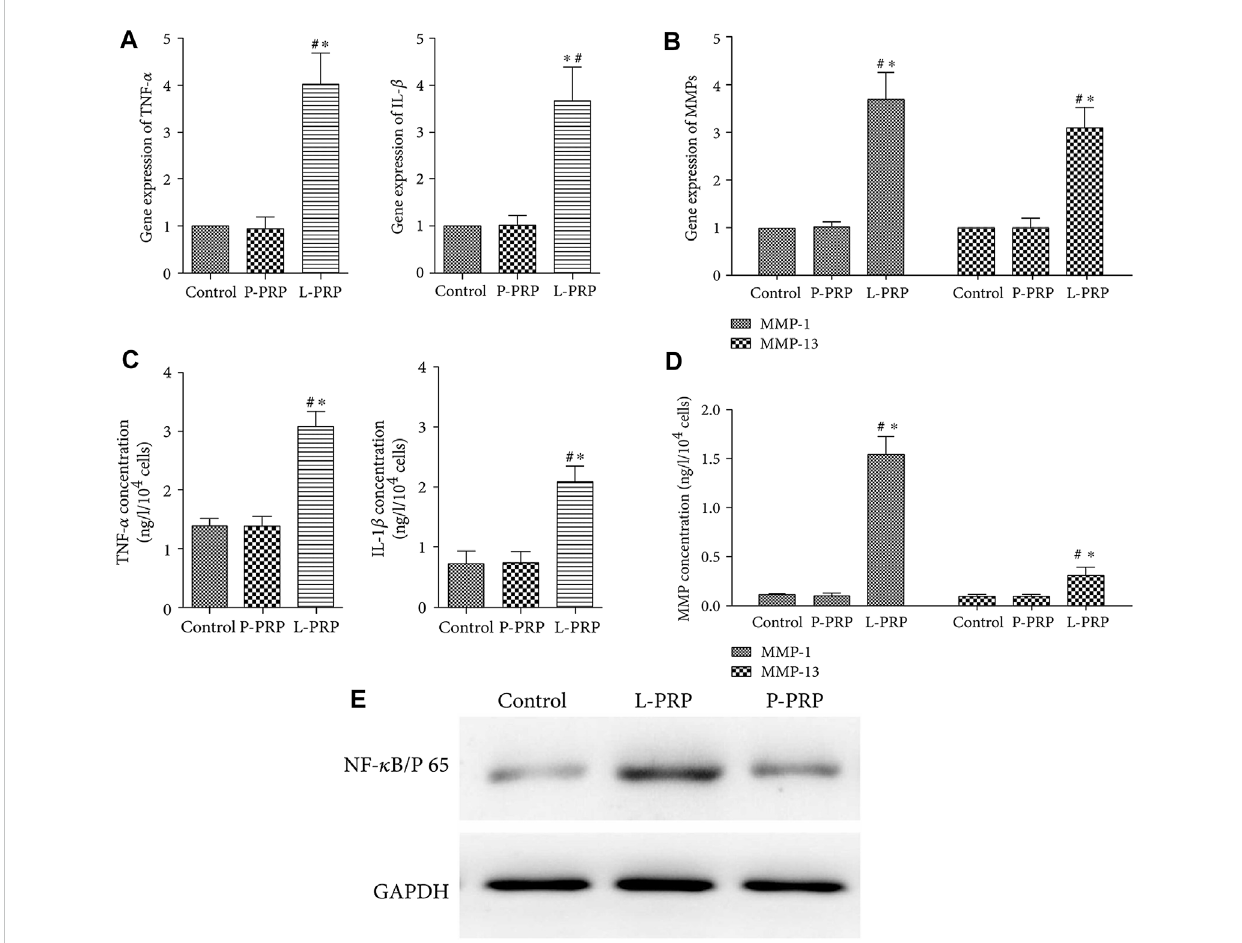
FIGURE 1 A comparison of the gene expression of in fl ammatory factors between groups with different leukocyte levels (A) . A comparison of gene expression of MMPs between groups with different leukocyte levels (B) . A comparison of the concentrations of in fl ammatory factors between groups with different leukocyte levels (C) . A comparison of the concentrations of MMPs between groups with different leukocyte levels (D) . West-blot comparison of the production of NF- κ B/p65 between groups with different leukocyte levels (E) . “ * ” p < 0.05 compared to P-PRP or L-PRP with controls, “ # ” p < 0.05 compared to L-PRP with P-PRP. Reproduced with permission from a previous publication (Jia et al.,